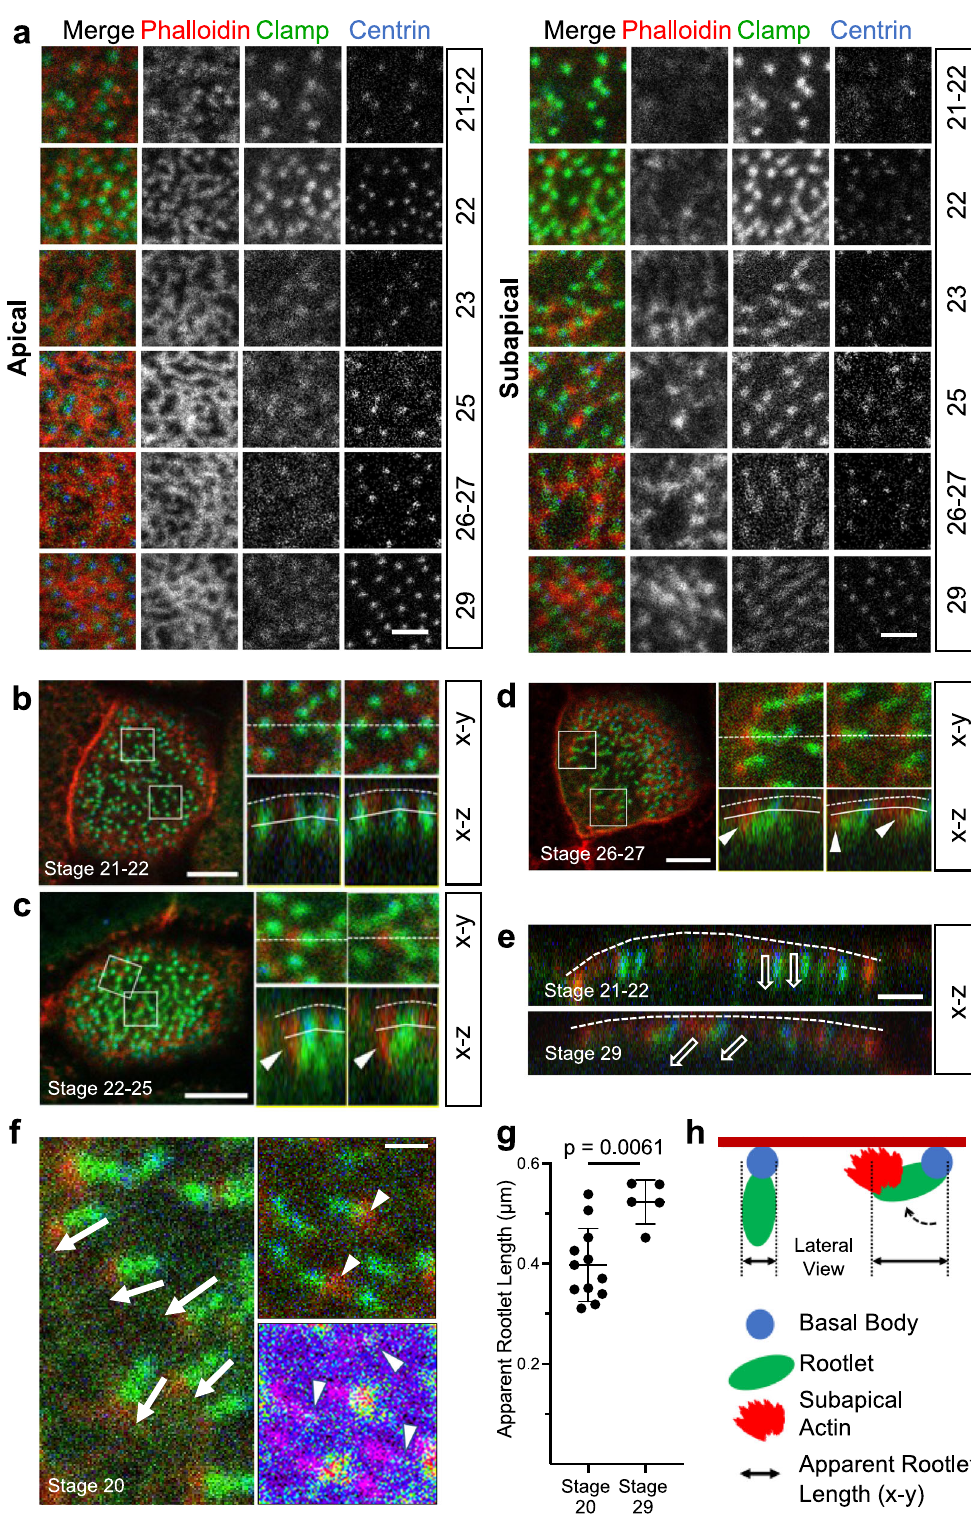
subapical actin layer (Fig. 4, Supplementary Fig. 3), implicating formin family members in nucleating subapical actin fi laments at the ciliary rootlet. Depletion of fhod3 , using three different morpholino oligonucleotides interfered with rootlet tilting, determined by measuring the apparent rootlet length and ciliary polarity (Supplementary Fig. 4). Xenopus fhod3 depletion pri- marily affected the subapical actin layer (Supplementary Fig. 5),